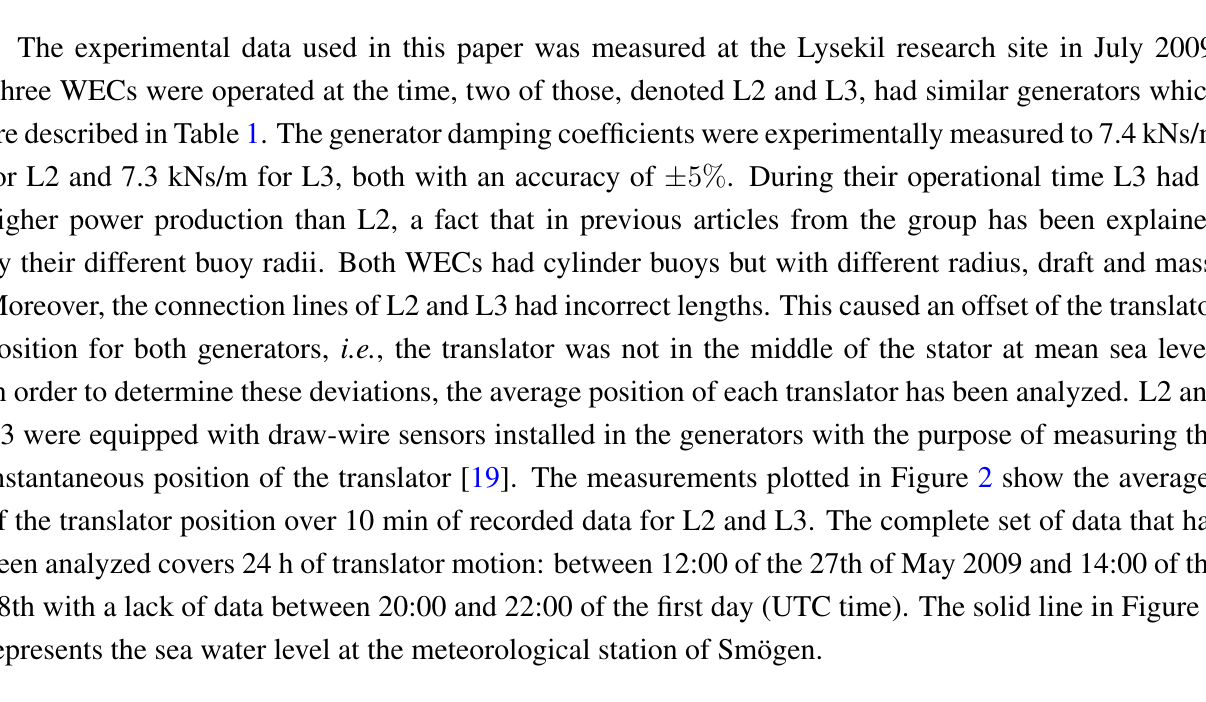
Table 1. Generator and buoy specifications for L2 and L3. The translator position offset and the pretension will vary with the sea level, here given for mean water